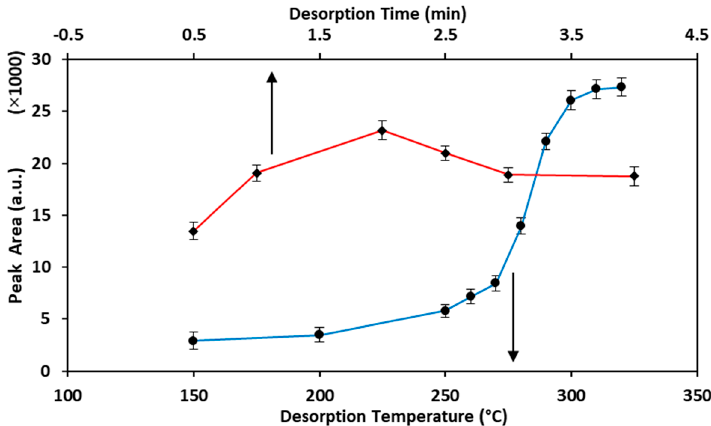
Figure 5. Study of desorption time and desorption temperature of the HS-SPME–GC-FID procedure for analysis of MTBE in solid samples (analyte concentration: 2 µg·g − 1 , extraction time: 15 min, extraction temperature: 60 °C).